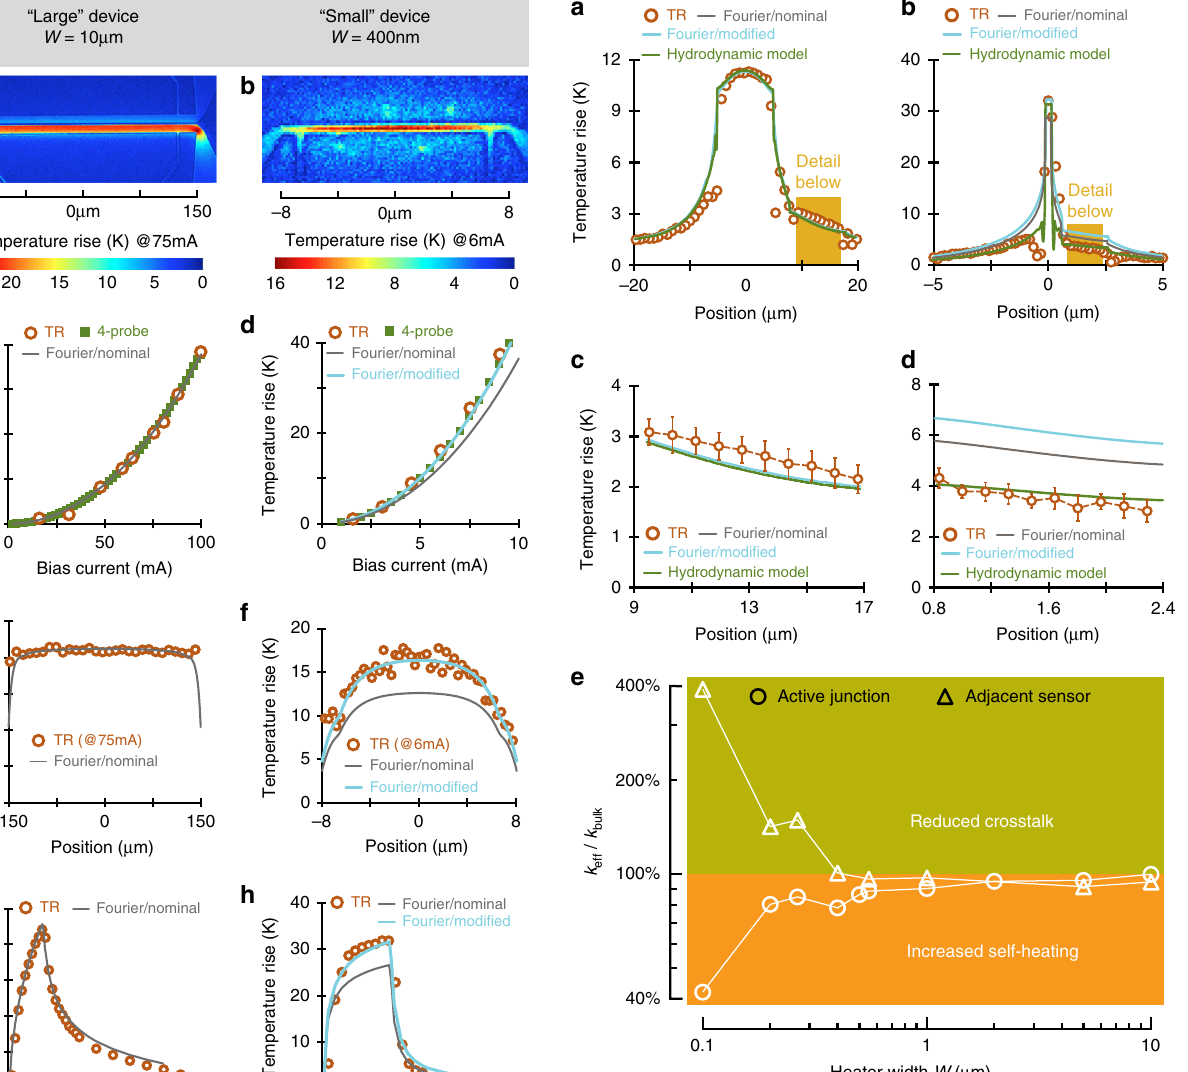
Fig. 3 Full- fi eld thermal image shows lower thermal crosstalk adjacent to nanoscale junctions. Thermal images (as those shown in Fig. 2a, b) also yield the temperature fi eld perpendicular to the heater lines (perpendicular cross section) for a a 10 μ m; and b a 265 nm heater line. The expanded view of temperature cross section (highlighted in the yellow boxes) is shown in part c for a 10 μ m; and d for a 265 nm heater line. Each data point is obtained by averaging few neighbouring pixels along horizontal axis, and the errorbars are the standard deviation of those pixels. It is evident that while the junction temperature can be accurately fi tted by conventional interpretations with reduced InGaAs thermal conductivity, these notably overpredict the thermal fi eld observed adjacent to small devices. The effective InGaAs thermal conductivity (normalised here to its nominal value κ fi t the measured temperature bulk ) required in diffusive simulations to pro fi le at the indicated locations is strongly dependent on characteristic dimension. This is shown in e . κ eff is de fi ned as the isotropic value needed in the Fourier model to match the measured temperatures at the heater or the thermometer. Although thermal transport around larger devices ( W greater than 1 μ m) obeys nominal Fourier theory almost perfectly, increasingly non- Fourier thermal behaviour is observed at/nearby the active junctions of